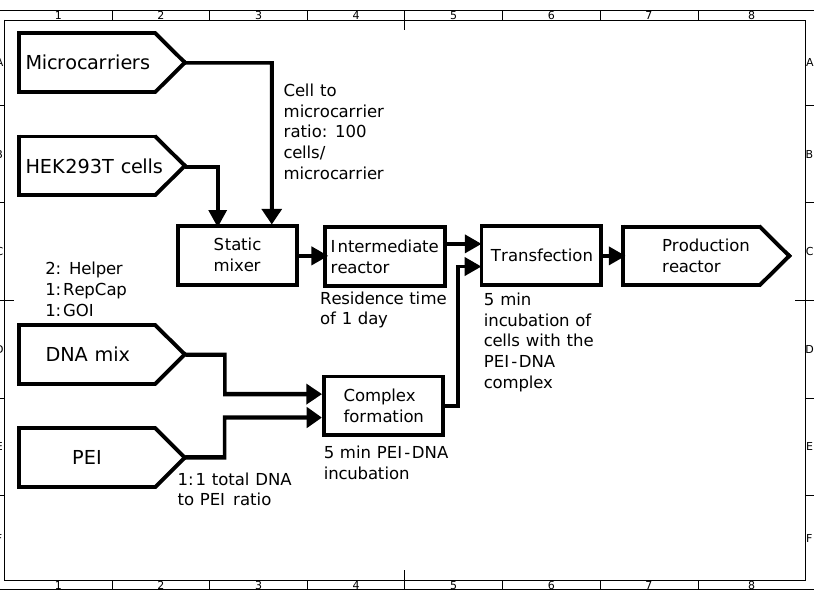
Figure 12. Block flow diagram of a semi-continuous transfection process. Microcarriers and HEK293T cells enter the process at the corresponding labels, where they are mixed in the static mixer; after which, the cells attach to the microcarriers. The inoculated microcarriers flow into the intermediate reactor which has a residence time of one day. The DNA mix and PEI enter the process at the corresponding labels where they are mixed at the given ratio in the complex formation step. The HEK293T cells attached to the microcarriers are then transfected with the formed complex, after which they are pumped into the production reactor.